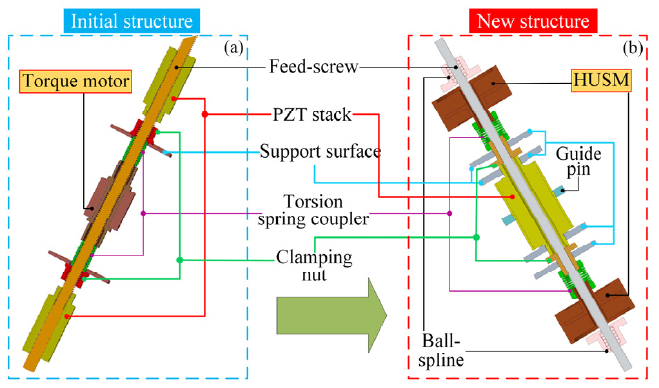
Figure 1. Improvement of design. ( a ) Initial structure; ( b ) new structure.